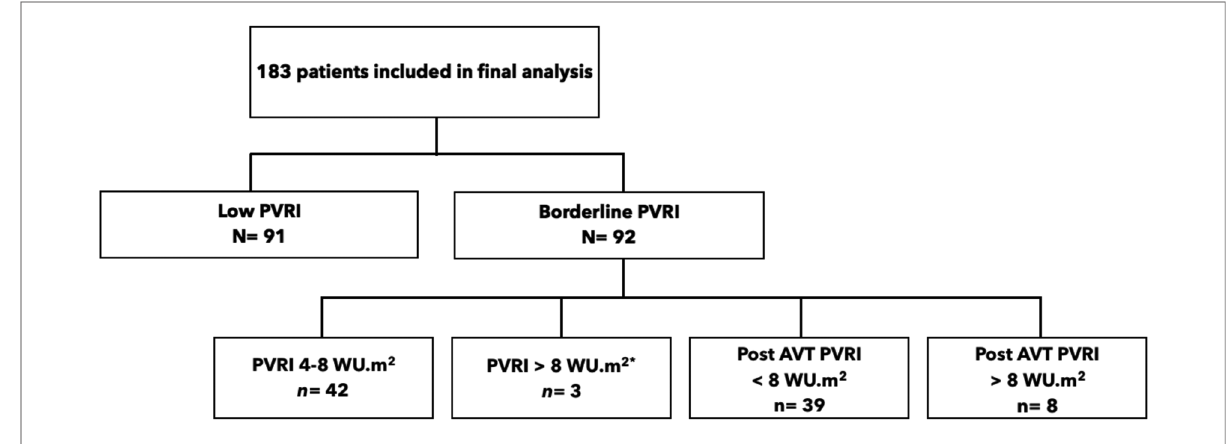
FIGURE 1 Schematic review of study sample.